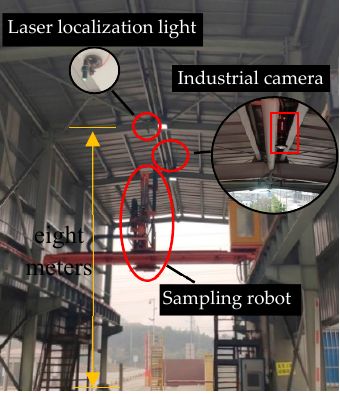
Figure 2. Wide-angle lens shooting.